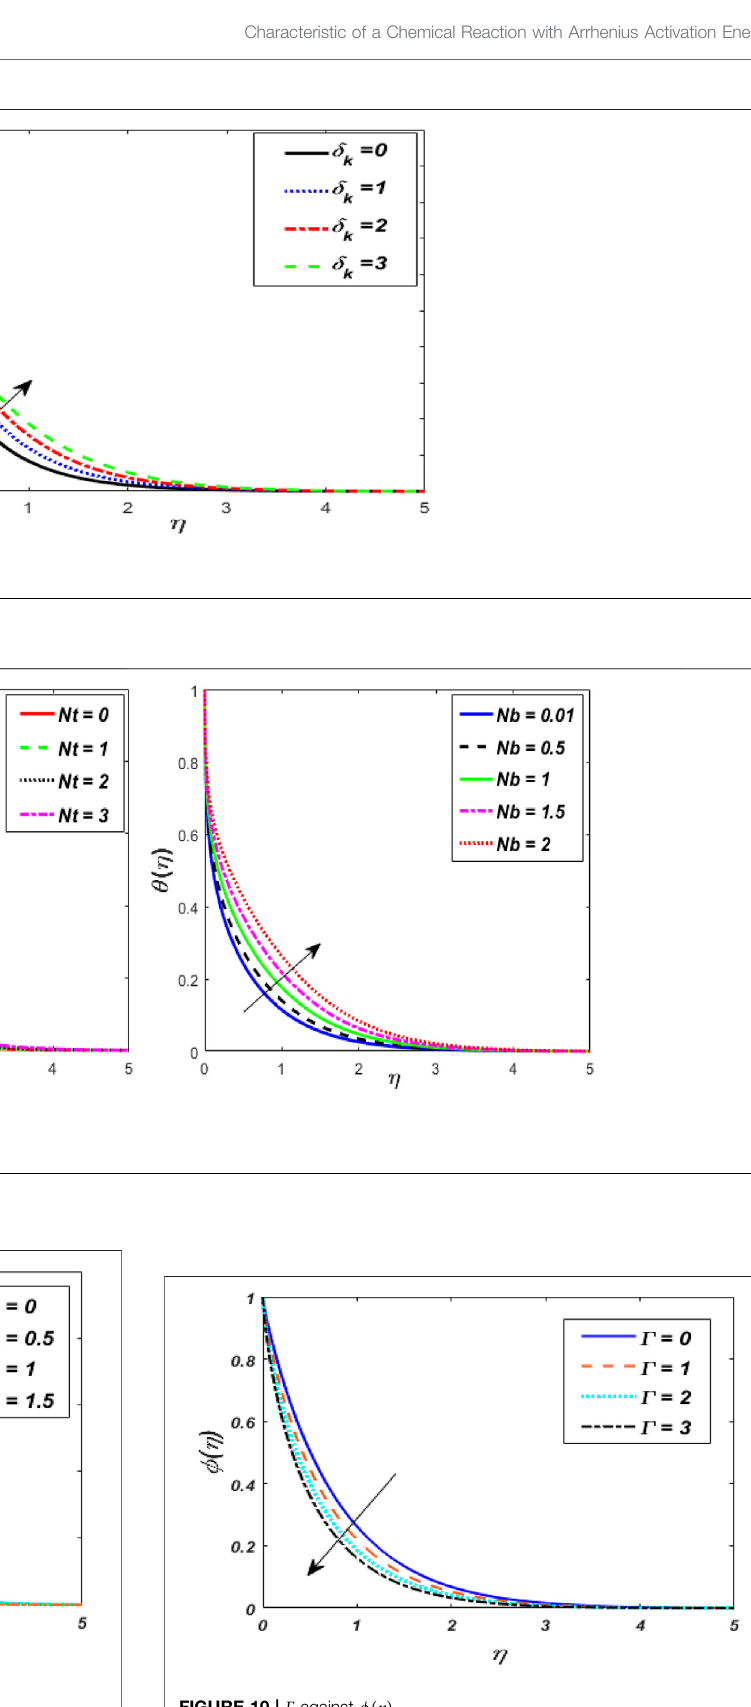
FIGURE 9 | Sc against ϕ ( η ) . FIGURE 10 | Γ against ϕ ( η ) .